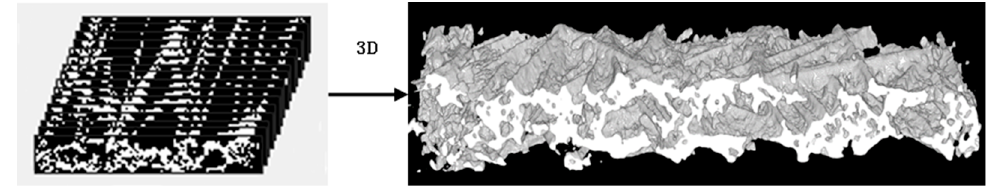
Figure 4. The 2D image slices and 3D structure of carbon paper GDL.